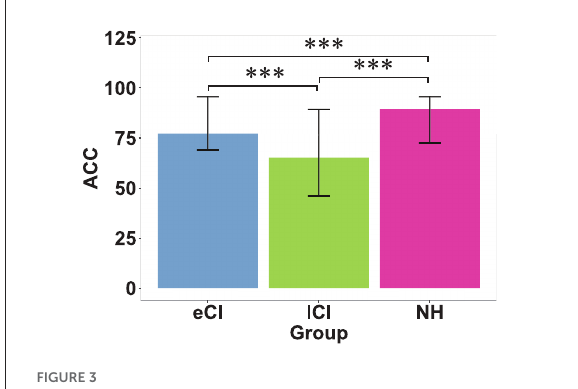
FIGURE3 Behavioral results of speech perception tests. Accuracy (ACC) of speech perception in children with early cochlear implantation (eCI), children with late cochlear implantation (lCI), and children with normal hearing (NH) groups. Speech perception was measured as the mean accuracy for tone, vowel, and consonant discrimination. The NH group performed the best, followed by the eCI group, and the lCI group performed the worst. ∗∗∗ p < 0.001.